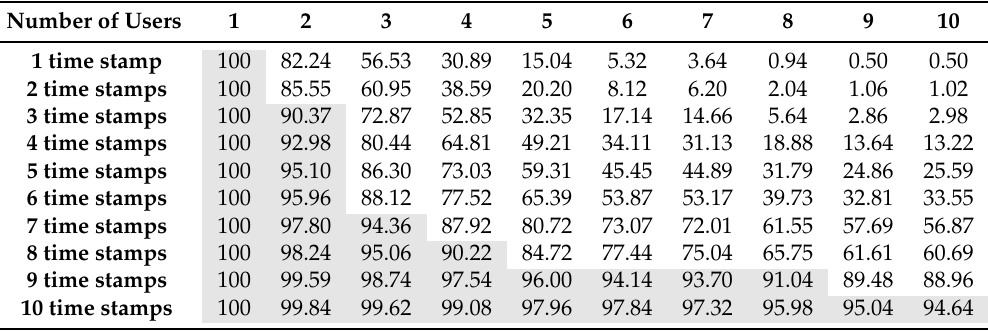
Table 1. Success rate according to the number of users and number of time stamps.